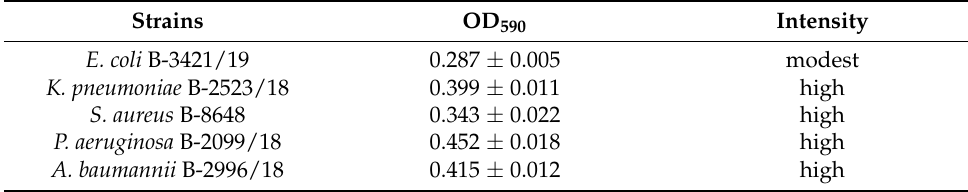
Table 2. Intensity of biofilm formation by clinical strains .